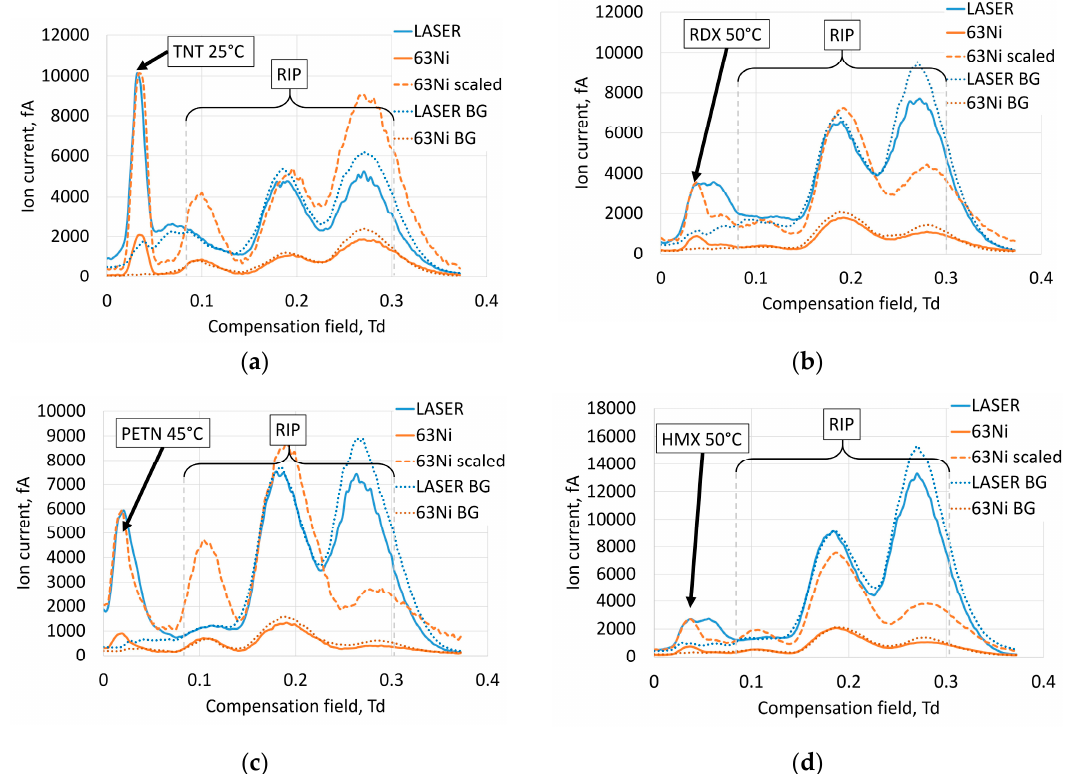
Figure 2. Comparison of ion mobility spectra at separation field of 45 Td from laser at I = 3.5 × 10 7 W/cm 2 and 63 Ni ionization: ( a ) TNT at 25 °C; ( b ) RDX at 50 °C; ( c ) PETN at 45 °C; ( d ) HMX at 50 °C.